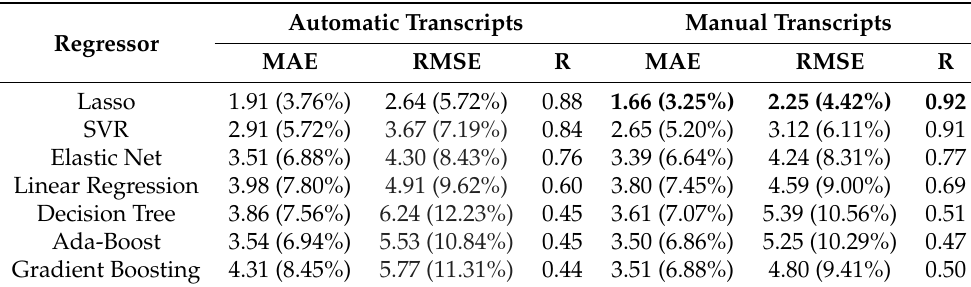
Table 3. The total practitioner’s competency rating prediction results using several regressors for manual and automatic transcriptions (the MAE and RMSE percentages of the total